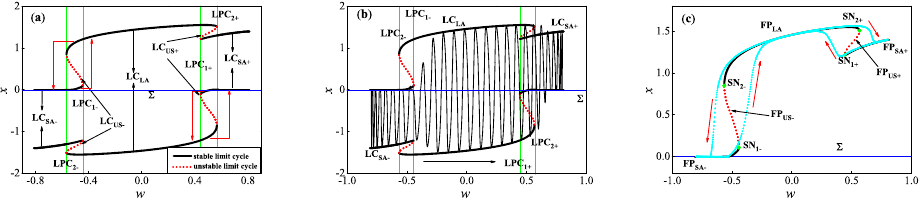
Figure 6. Generation mechanism analysis for the MTSOs with Ω = 0.01. ( a ) One-parameter conven- tional bifurcation diagram of spike attractors; ( b ) the superimposition of one-parameter bifurcation diagram of spike attractors and one segment of trajectory with τ ∈ [ 3 π + 4 n π relaxation oscillation equivalent to the MTSOs in Figure 3. Table 2. Bifurcations of spike attractors as well as the abbreviations and parameter values. Bifurcation Abbreviation Parameter Value Fold bifurcation of limit cycles Multi-sliding